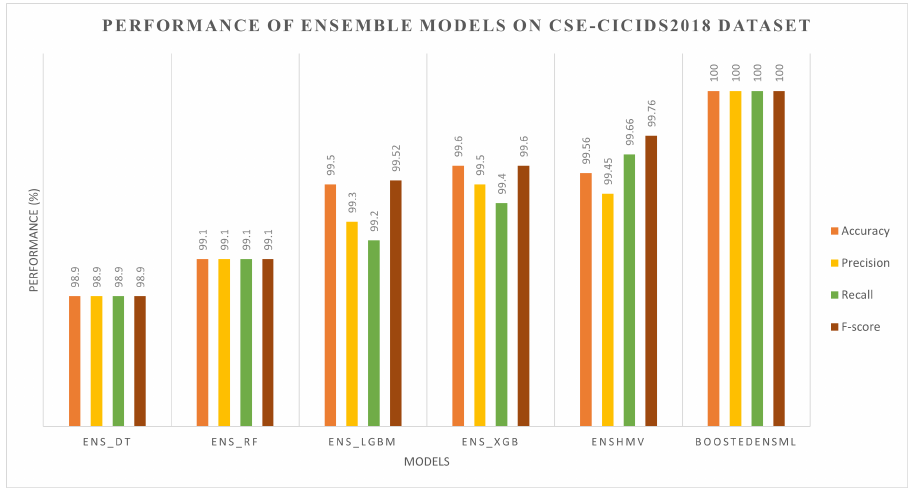
Figure 4. Performance evaluation of ensemble models on the CIC-IDS2018